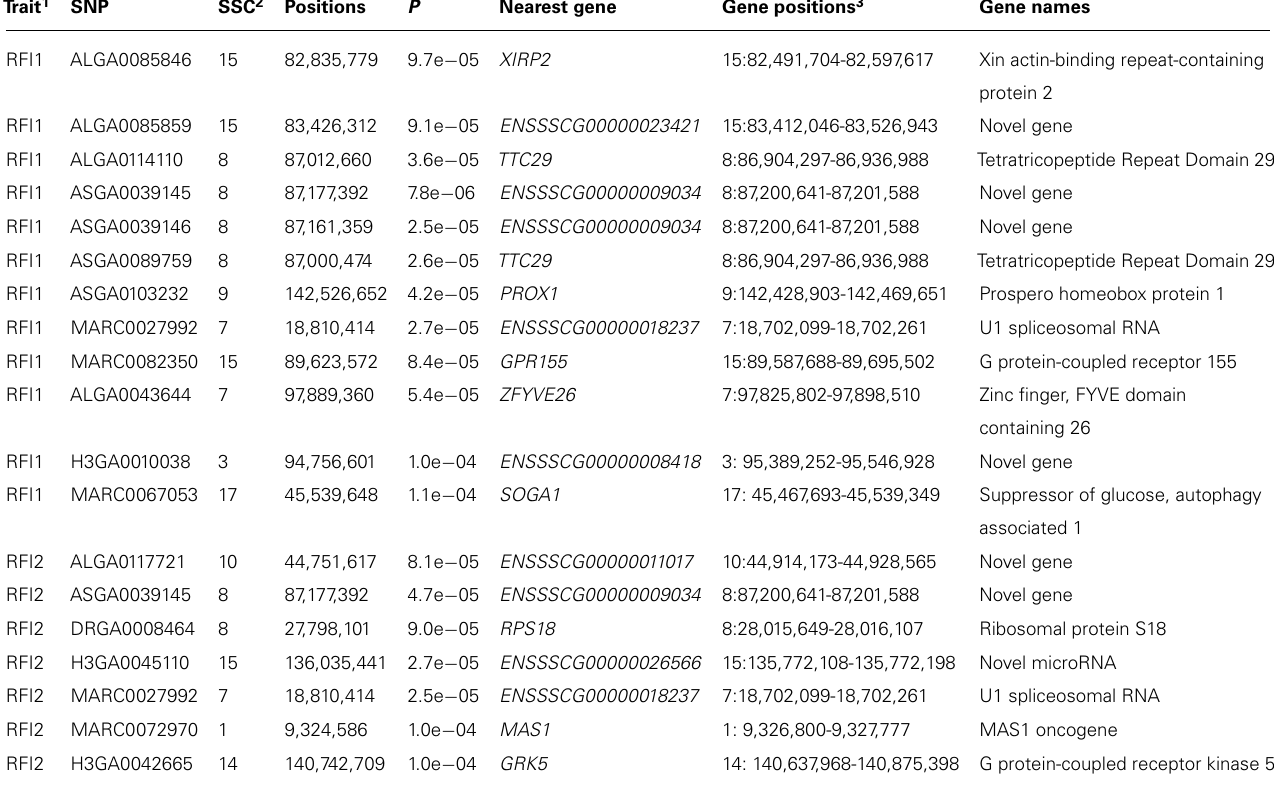
Table 1 | Genome-wide significant SNPs for residual feed intake inYorkshire. Trait 1